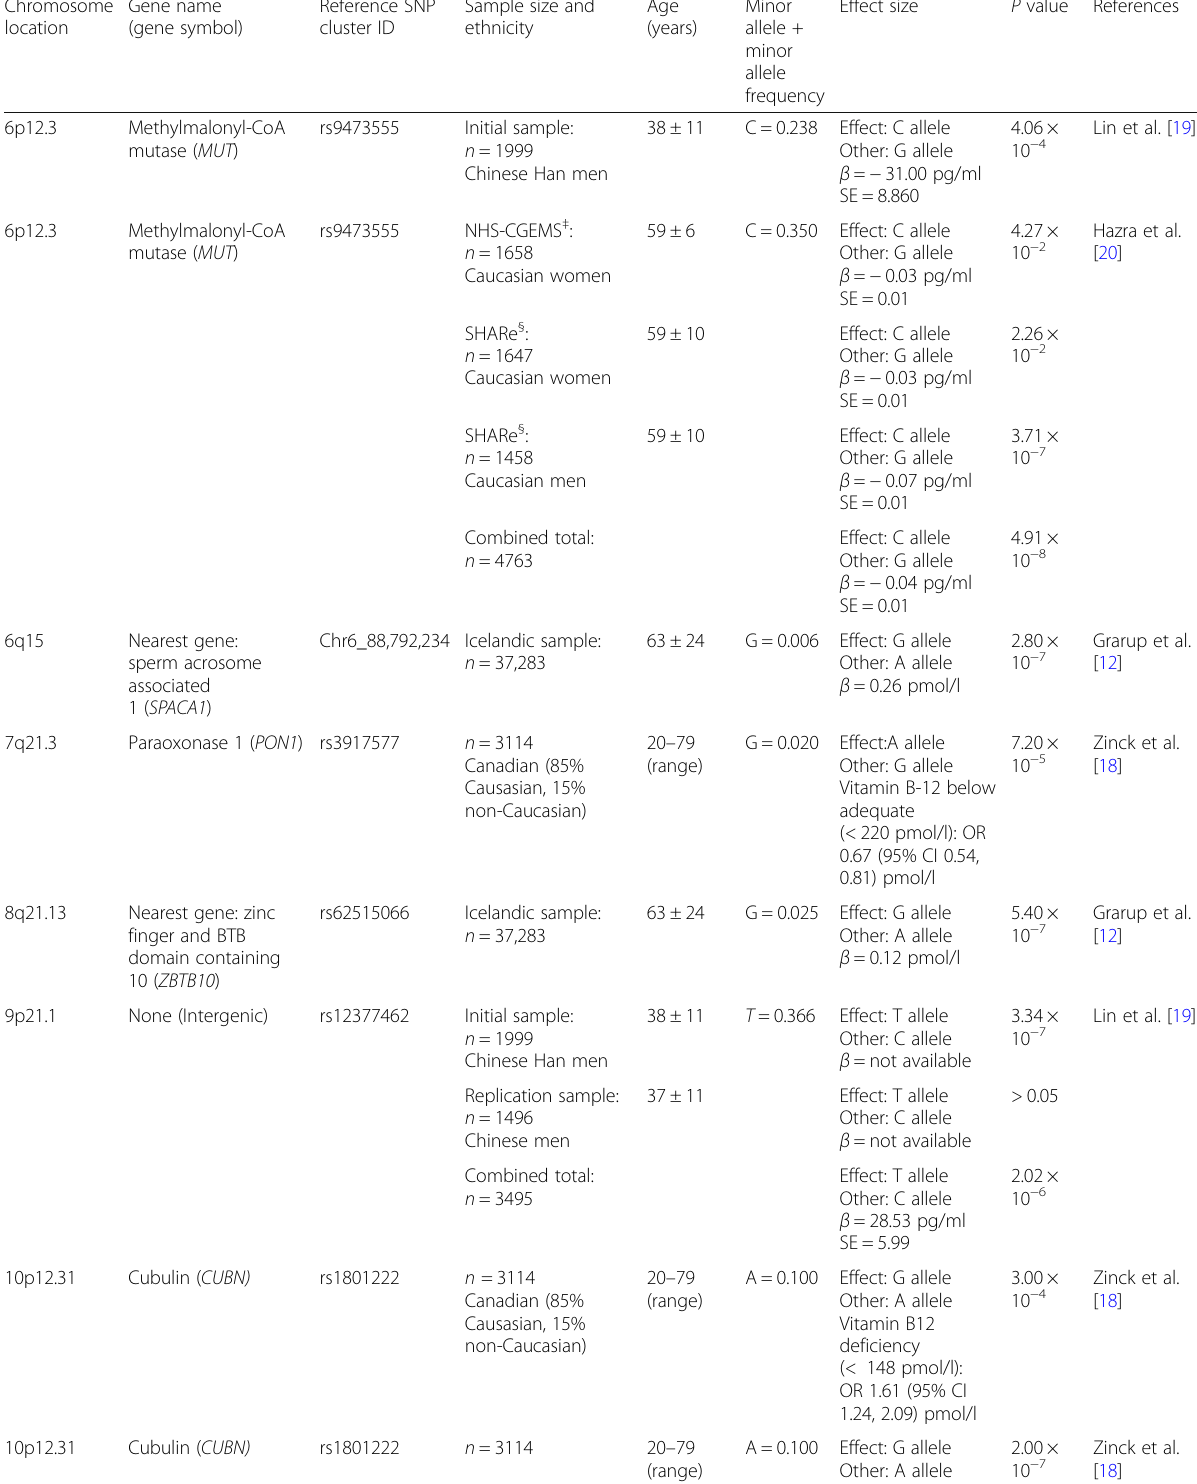
Table 1 Genome-wide association studies showing the association of SNPs with vitamin B12 concentrations. Genome-wide association studies testing the association between SNPs and vitamin B12 concentrations. The chromosome location, gene name, reference SNP cluster ID, sample size and ethnicity, mean age, observed frequency of the minor allele in the population, effect size and P value are shown in the table. The order of SNPs reflects the order of the chromosome location